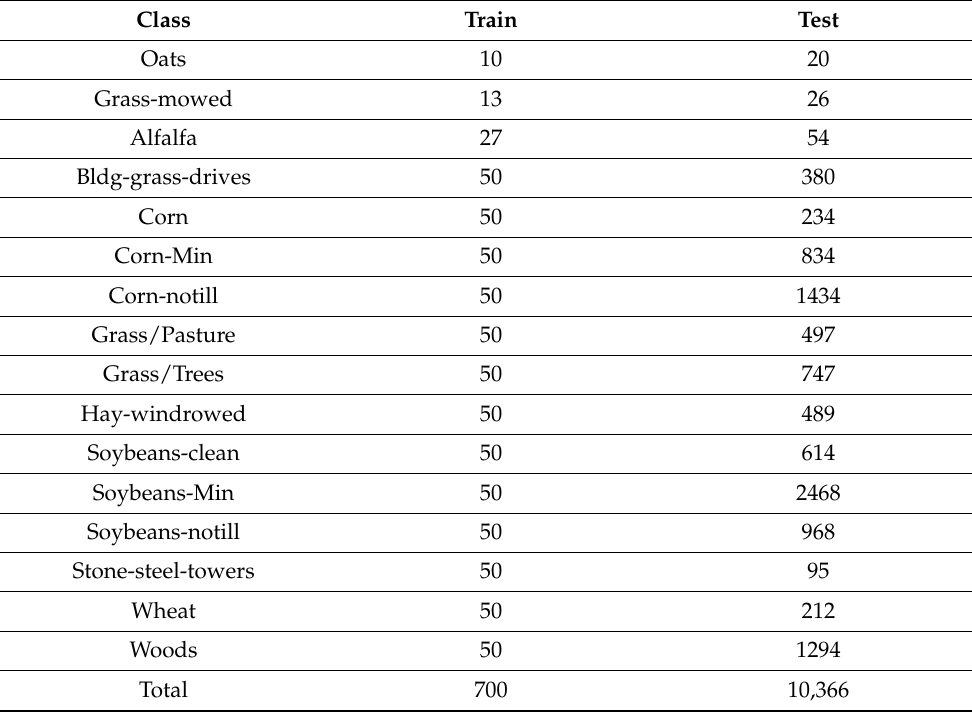
Table 3. Number of labelled samples and information classes (Indian